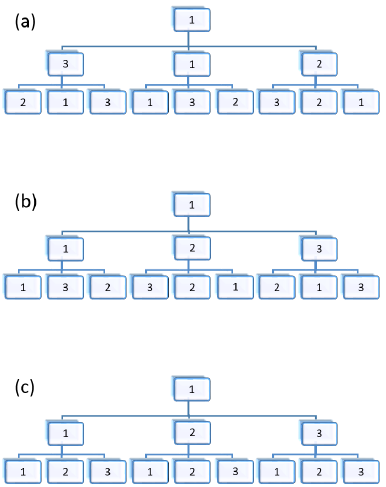
Figure 6. The sorting process of a hierarchical tree from top to bottom: ( a ) disordered multi-tree; ( b ) sorted second layer nodes; and ( c ) sorted leaf nodes.